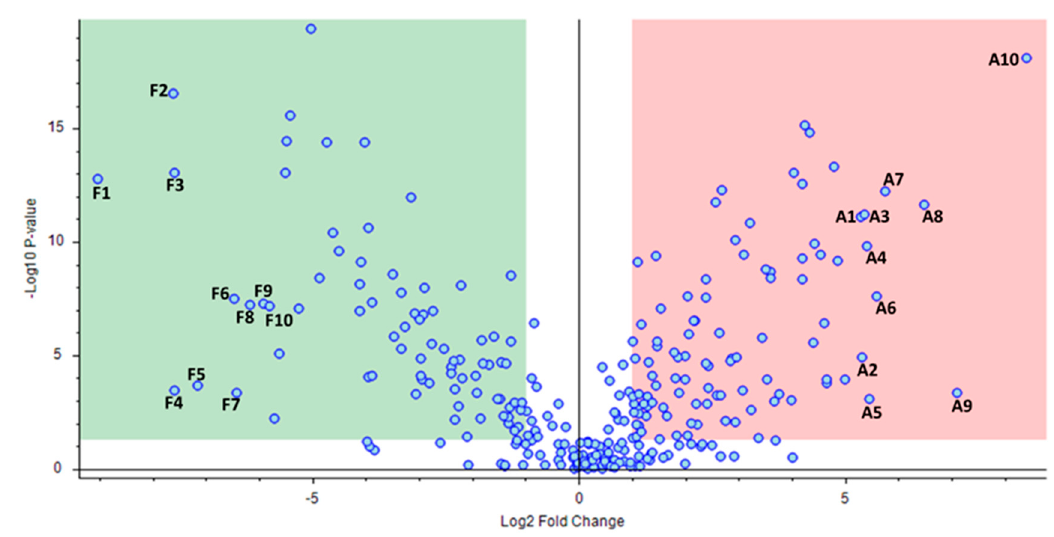
Figure 3. Comparative analysis of the identified compounds in “aszú” and “furmint” wines. The “x” axis represents the Log2 fold-change values, while the “y” axis indicates the –Log10 p values. The green box sows the compounds having statistically significantly higher level in “furmint” compared to “aszú”, while the red box indicates compounds with statistically significantly higher level in “aszú” compared to “furmint”. The top 10 components that showed the highest change in “furmint” and in “aszú”, repsepectively, are denoted with numbers (F1–F10 and A1–A10, respectively). F1: DL- isoleucyl-DL-isoleucyl-DL-histidine, F2: DL-alanyl-DL-isoleucyl-DL-isoleucyl-DL-threonine, F3: DL- leucyl-DL-leucyl-DL-leucine, F4: DL-valyl-DL-valyl-DL-valine, F5: L-phenylalanyl-L-leucine, F6: DL- tyrosyl-DL-prolyl-DL-isoleucine, F7: (2S)-2-[(2R)-7-(2-Methoxyethoxy)-5,8-dimethyl-1,2,3,4- tetrahydro-2- naphthalenyl]-1-(1-piperidinyl)-1-propanone, F8: DL-isoleucyl-DL-alpha-glutamyl-DL-lysine, F9: 1-(4- Methoxyphenyl)-N-[3-(4-morpholinyl)propyl]-5-oxo-3-pyrrolidinecarboxamide,